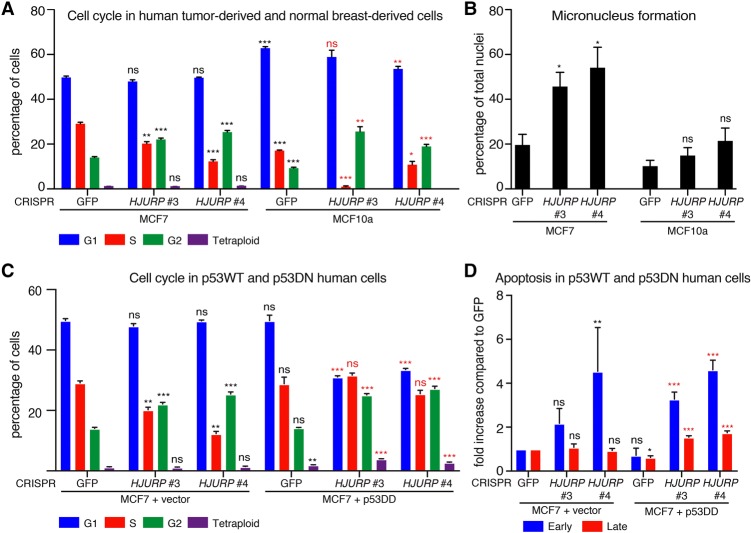
Human transformed MCF7 cells display aneuploidy following HJURP depletion. (A) Quantification of cell cycle analysis by flow cytometry (Edu/PI) in MCF7 human breast tumor-derived cells or MCF10a immortalized nontransformed breast cells, both with intact p53, 6 d after CRISPR lentiviral transduction and following puromycin selection. Mean percentages of cells ± SEM of triplicates are shown for G1, S, G2/M, and tetraploid/aneuploid (>4N) populations. Statistical significance is shown where relevant. (*) P < 0.05; (**) P < 0.005; (***) P < 0.0005, t-test. (Black asterisks) Significance compared with GFP control in MCF7 cells; (red asterisks) significance compared with GFP control in MCF10a cells. (B) Quantification of micronucleus formation in MCF7 cells 6 d after CRISPR lentiviral transduction and following puromycin selection. Nuclei were stained with DAPI; at least 200 nuclei per CRISPR condition were counted. See Supplemental Figure S6B for corresponding immunofluorescence images. (C) Quantification of cell cycle analysis by flow cytometry (Edu/PI) in MCF7 cells transduced with a control vector (MCF7 + vector) or p53 DD 6 d after CRISPR lentiviral transduction and following puromycin selection. Mean percentages of cells ± SEM of triplicates are shown for G1, S, G2/M, and tetraploid/aneuploid (>4N) populations. Statistical significance is shown where relevant. (**) P < 0.005; (***) P < 0.0005, t-test. (Black asterisks) Significance compared with GFP control in MCF7 control cells; (red asterisks) significance compared with GFP control in MCF7 + p53 DD cells. (D) Quantification of apoptosis by flow cytometry (Annexin V/PI) in MCF7 cells transduced with a control vector (MCF7 + vector) or p53 DD 6 d after CRISPR lentiviral transduction and following puromycin selection. Mean percentages of cells ± SEM of triplicates are shown for G1, S, G2/M, and tetraploid/aneuploid (>4N) populations. Statistical significance is shown where relevant. (*) P < 0.05; (***) P < 0.0005, t-test. (Black asterisks) Significance compared with GFP control in MCF7 control cells; (red asterisks) significance compared with GFP control in MCF7 + p53 DD cells.